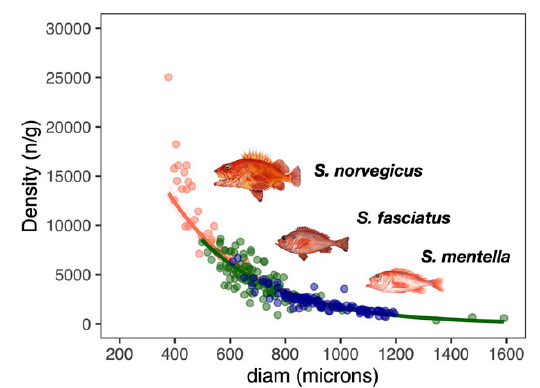
Fig. 2. – Relationship between oocyte diameter and oocyte density (number of oocytes/g) for species of the genus Sebastes sampled on the Flemish Cap bank ( S. fasciatus with green dots) and in the Irminger Sea and Iceland ( S. norvegicus and S. mentella with coral and blue dots, respectively). No significant differences were observed between